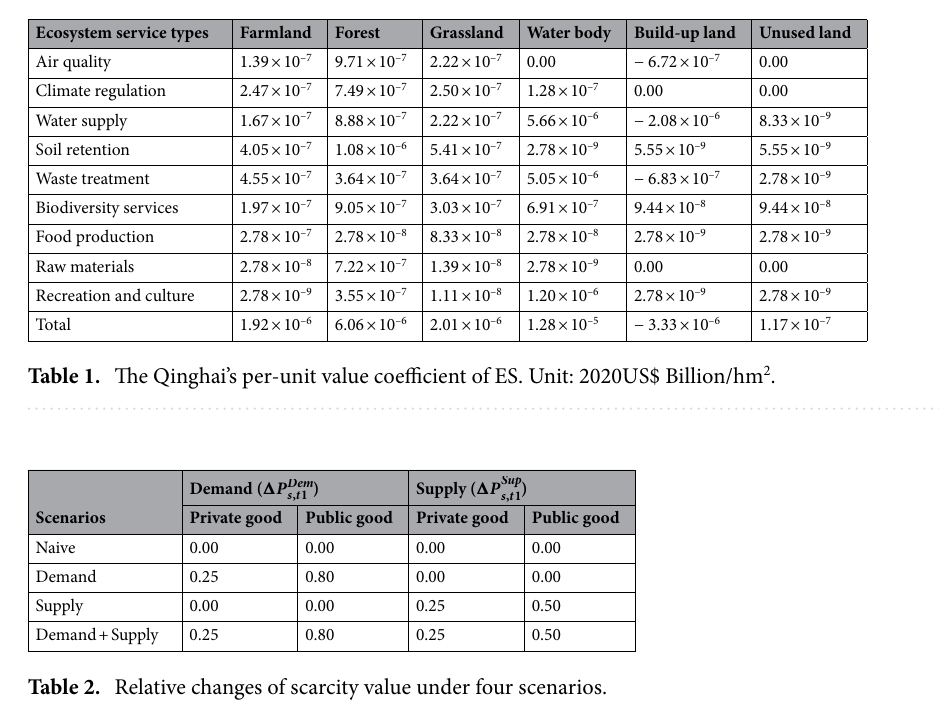
Ecosystem service types